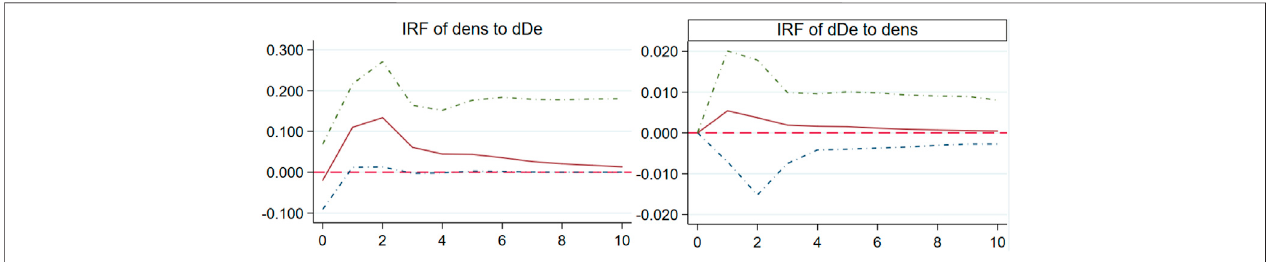
FIGURE 1 | Impulse response analysis